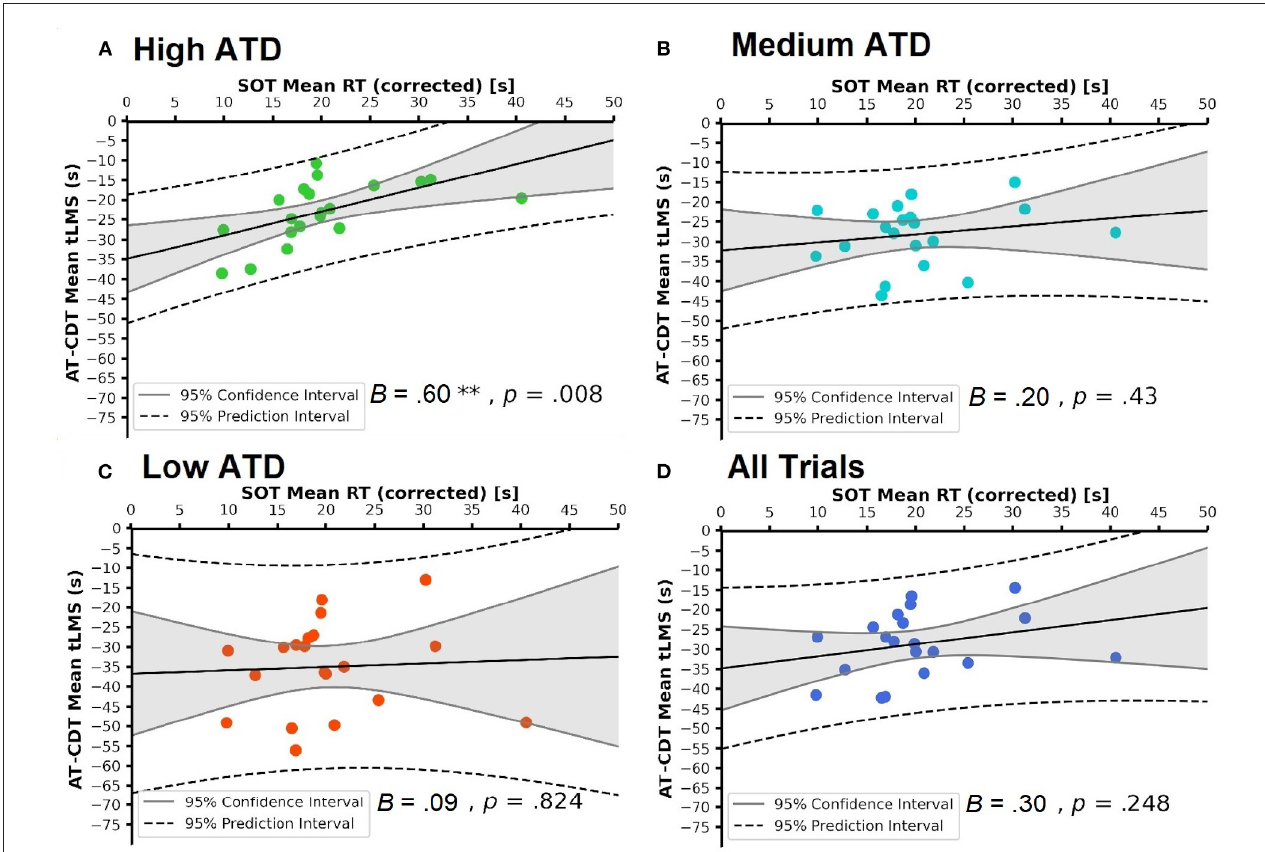
FIGURE 8 | Scatter-plots showing the linear relationships between mean Spatial Orientation Test (SOT) corrected reaction times (RT) and mean Air Traffic Conflict Detection Task (AT-CDT) time to loss of minimum separation (tLMS) under each of (A–C) three air traffic density (ATD) conditions and over (D) all AT-CDT test trials. Raw regression coefficients are shown. (A) shows the significant correlation emanating from the high ATD condition. 95 % confidence and prediction intervals are shown. In all plots, no data points lie beyond the 95 % prediction interval, showing the absence of